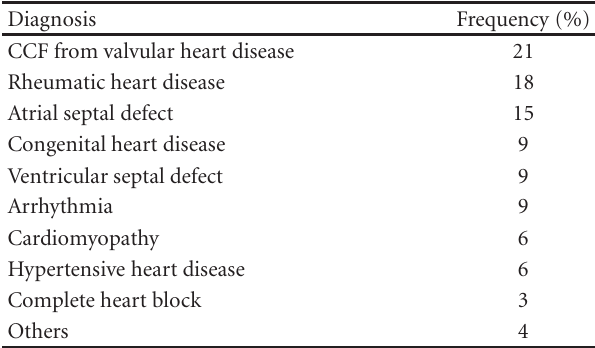
Table 2: Common clinical